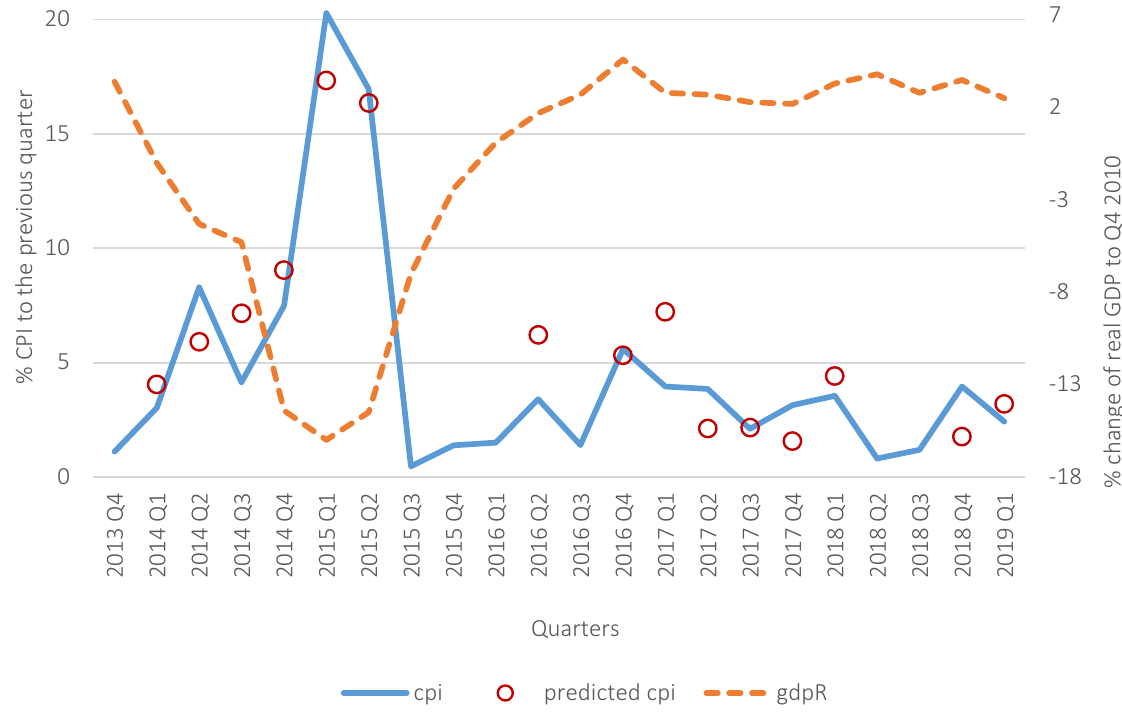
Figure 2. The model of the result of inflation targeting and the real GDP rate in Ukraine for 2013 Q4–2019 Q1,